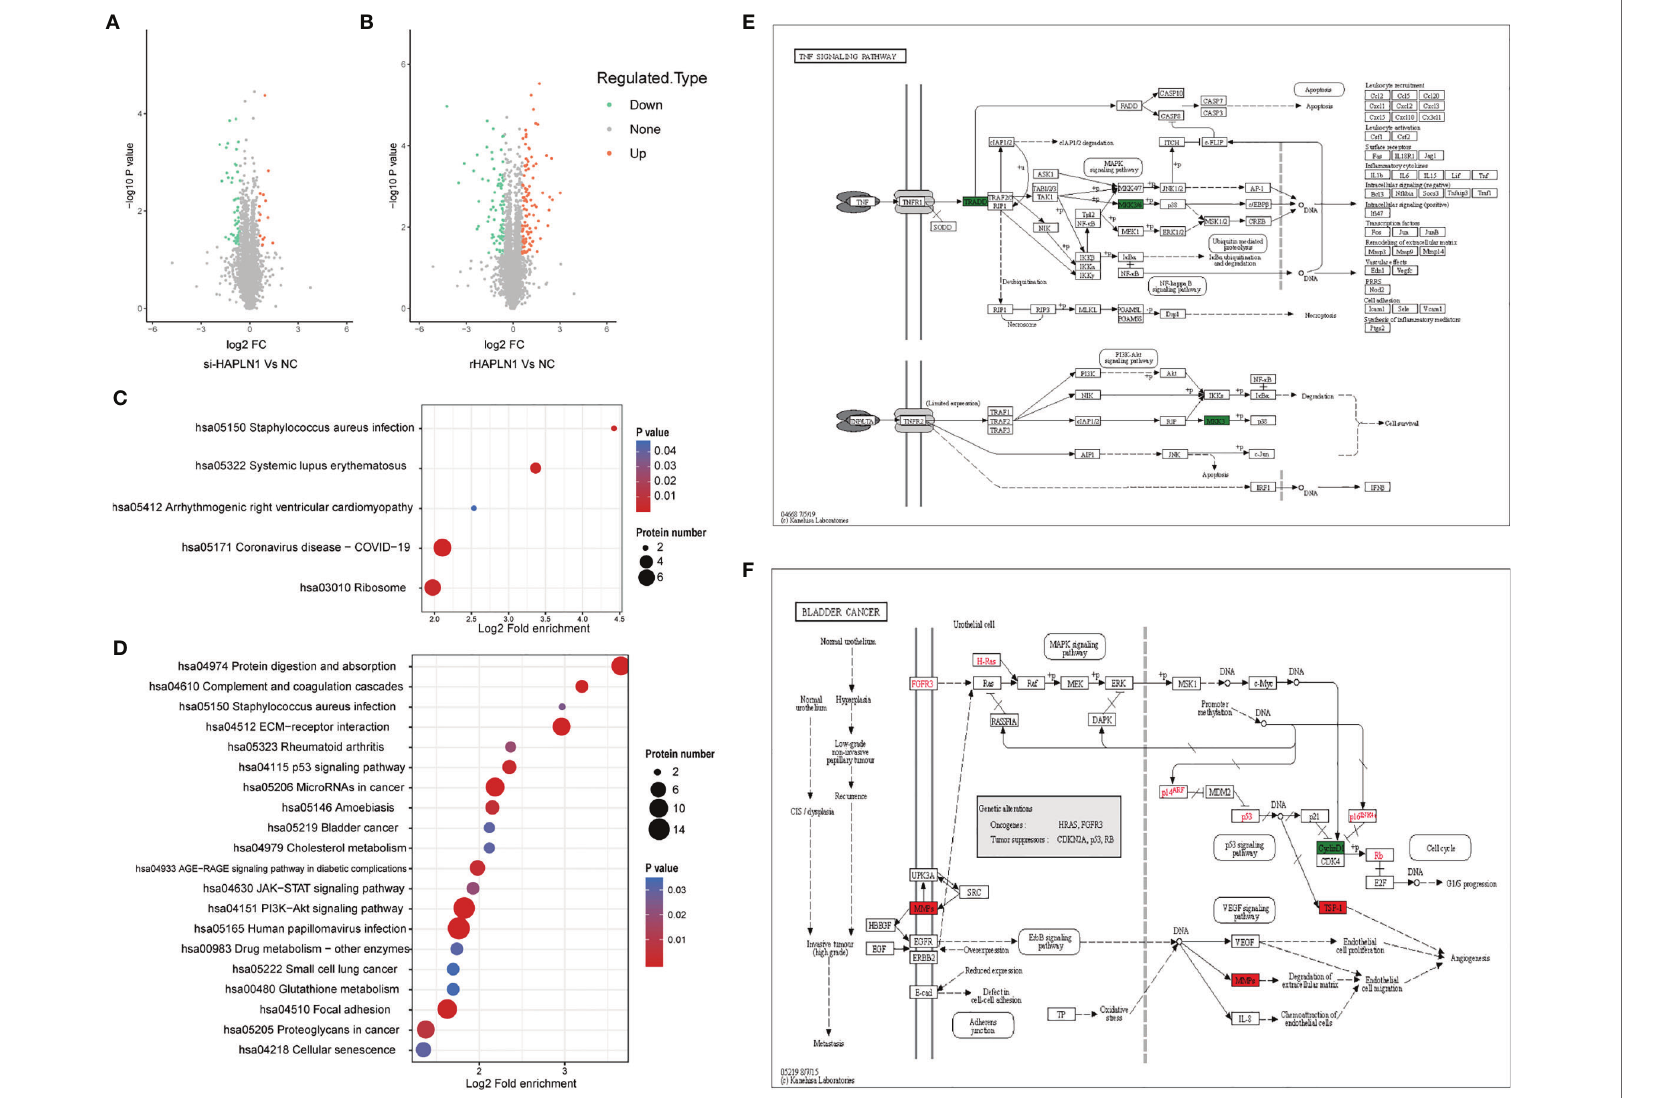
FIGURE 7 | Proteomic analysis of si-HAPLN1- and rHAPLN1-treated RA-FLSs. (A, B) Among the quanti fi able proteins, 14 were up-regulated and 47 were down-regulated by si-HAPLN1 transfection. There were 101 proteins up-regulated, and 82 were down-regulated by rHAPLN1 treatment compared to NC. (C) KEGG enrichment analysis shows the pathways associated with DEPs of si-HAPLN1-treated RA-FLSs. (D) KEGG enrichment analysis shows the top 20 pathways associated with DEPs of rHAPLN1-treated RA-FLSs. (E) DEPs of si-HAPLN1-treated RA-FLSs enriched in the TNF signaling pathway. (F) . DEPs of rHAPLN1- treated RA-FLSs enriched in the bladder cancer pathway. Targets in red blocks represent up-regulation, in green blocks represent